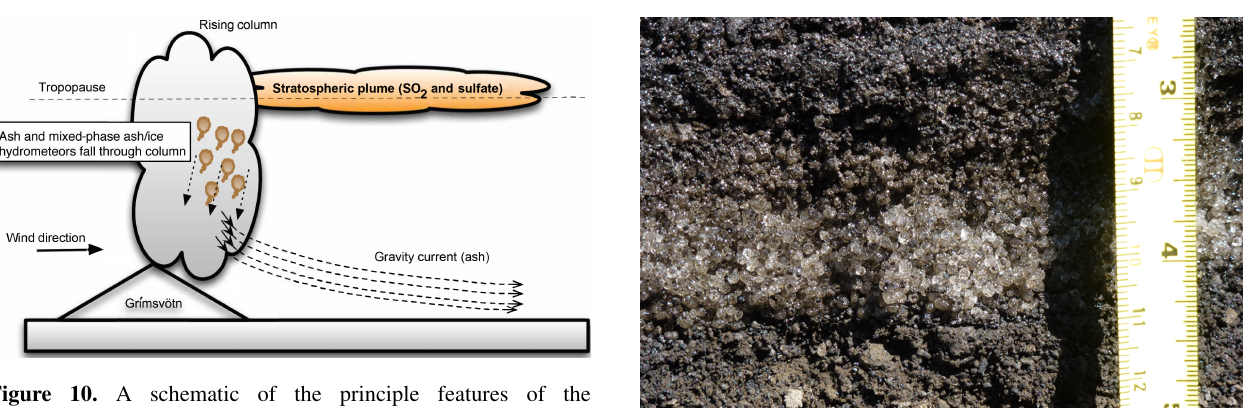
Figure 10. A schematic of the principle features of the Grímsvötn eruption column. Large hydrometeors composed of ash aggregates and mixed-phase ash and ice particles fall through the column, competing with the upward force of the eruption, eventu- ally causing the column to collapse as well as the generation of one or more PDCs, pushing an outflow of ash-rich air into the lower troposphere. Ash rises from the PDC and falls in the collapsing column. A high-level plume of SO 2 with some ash penetrates the tropopause. The height range of the gravity current (or pyroclastic density current) is unknown but likely to extend from the ground to the top of the observed ash skirt.